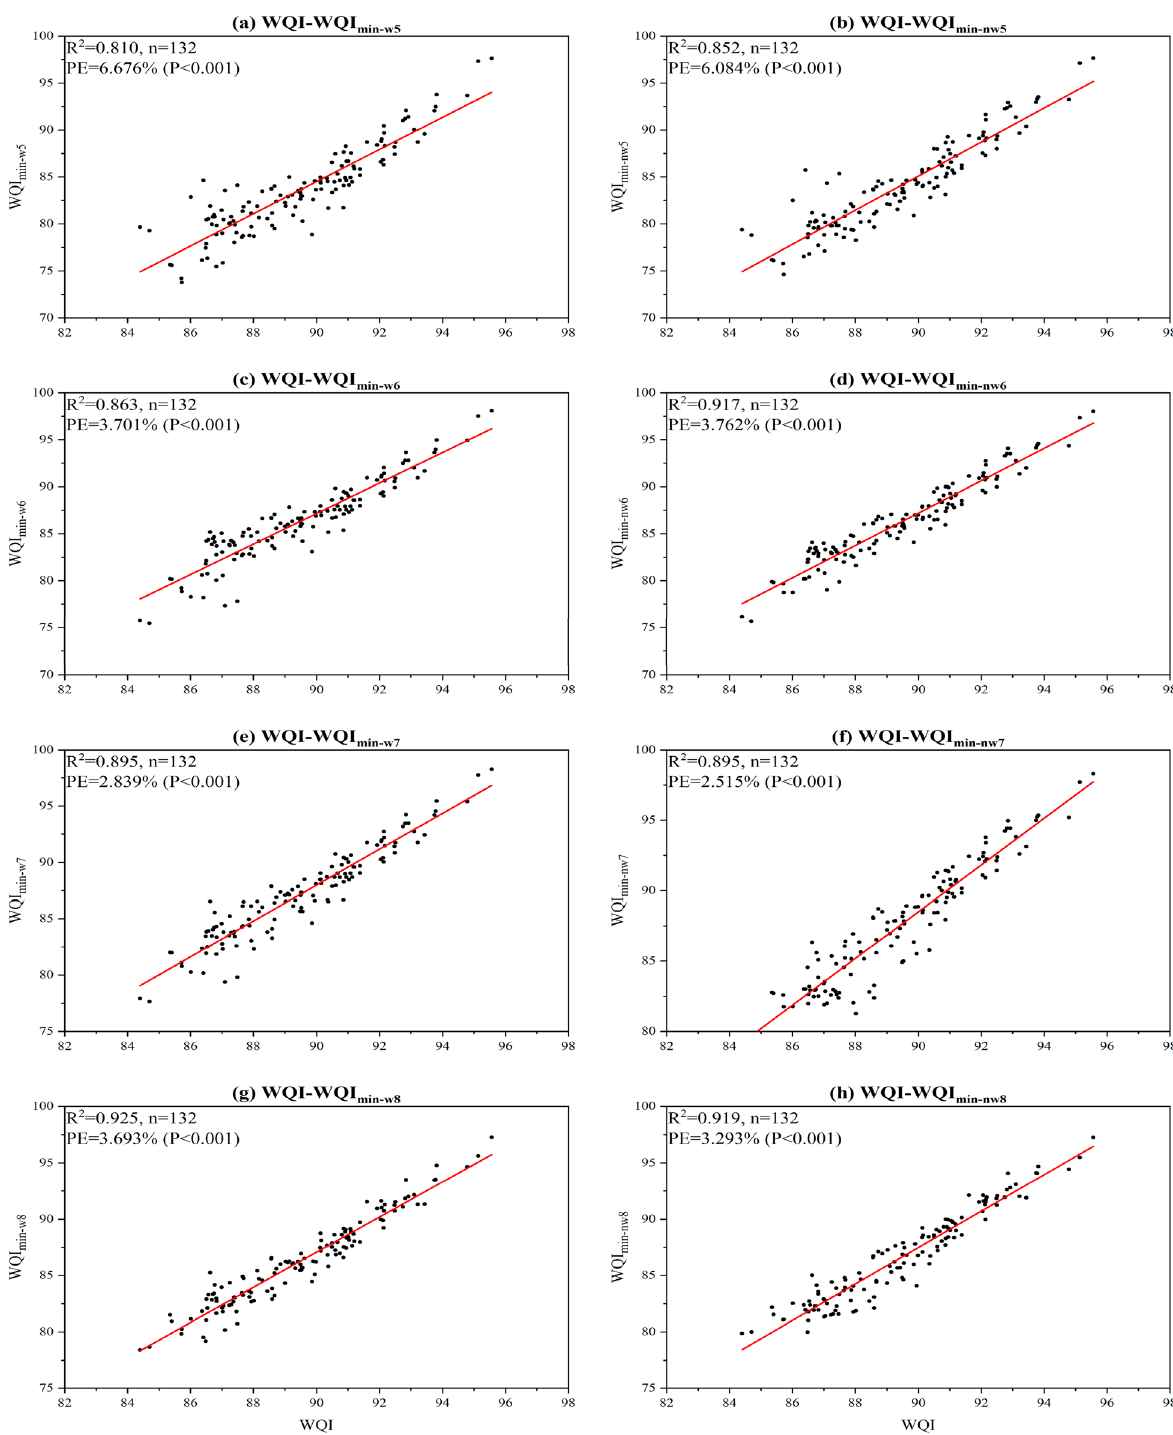
Figure 5. Comparison of the WQI and WQI min values based on the testing dataset (the parameters for each WQI min model are shown in Table